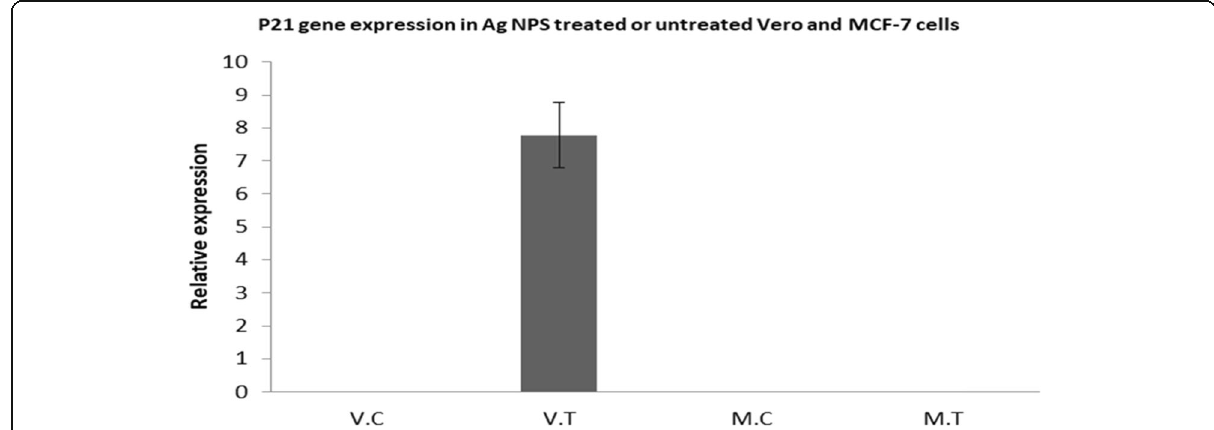
Fig. 8 P21 relative expression in MCF-7 and Vero cell treated or untreated with AgNPs. Total RNA was extracted, reverse transcribed, and the synthesized DNA was used as a template for qPCR relative expression assay using SYBR green master mix. Data were analyzed by ΔΔ CTs and normalized to ( β actin) house-keeping gene ( t test P < 0.058,